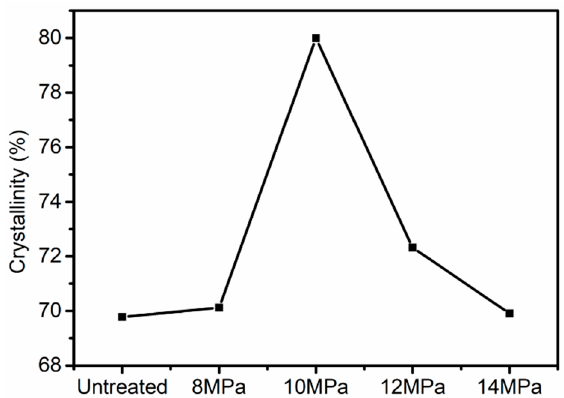
Figure 4. Crystallinity of PAN fibers treated at different pressures in Sc ‐ CO 2 .